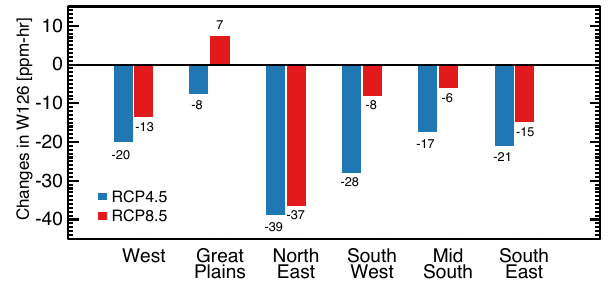
Figure 12. Simulated 2050–2000 summertime changes in O 3 W126 for RCP4.5 (blue) and RCP8.5 (red) averaged over the six US cli- matic regions identified in Fig. 4. Numerals indicate the simulated changes in O 3 W126 (ppmh − 1